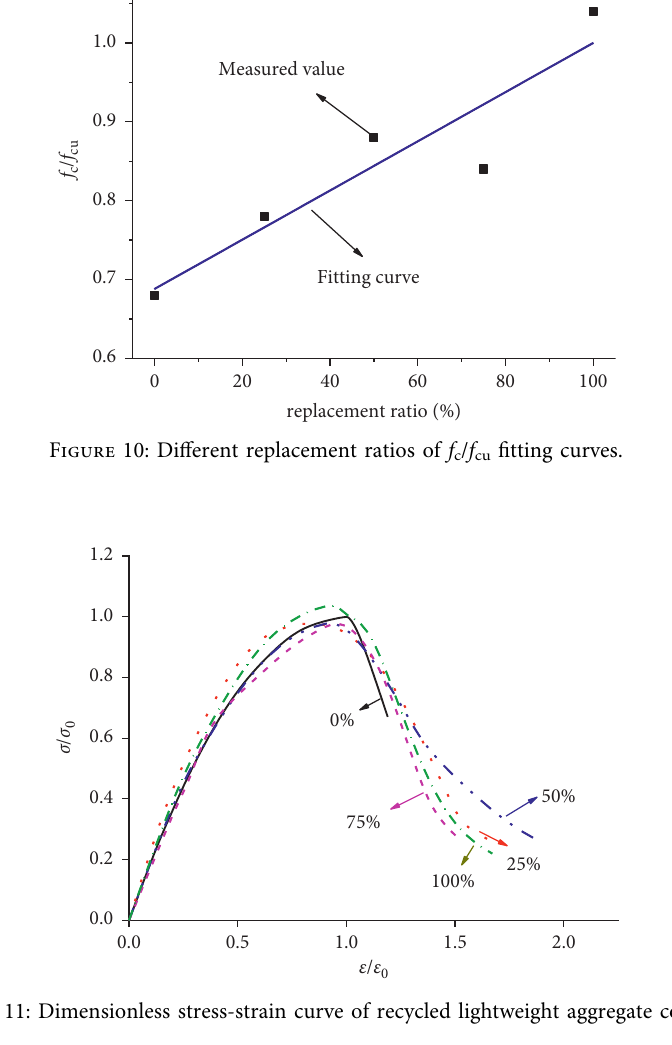
Figure 11: Dimensionless stress-strain curve of recycled lightweight aggregate concrete.